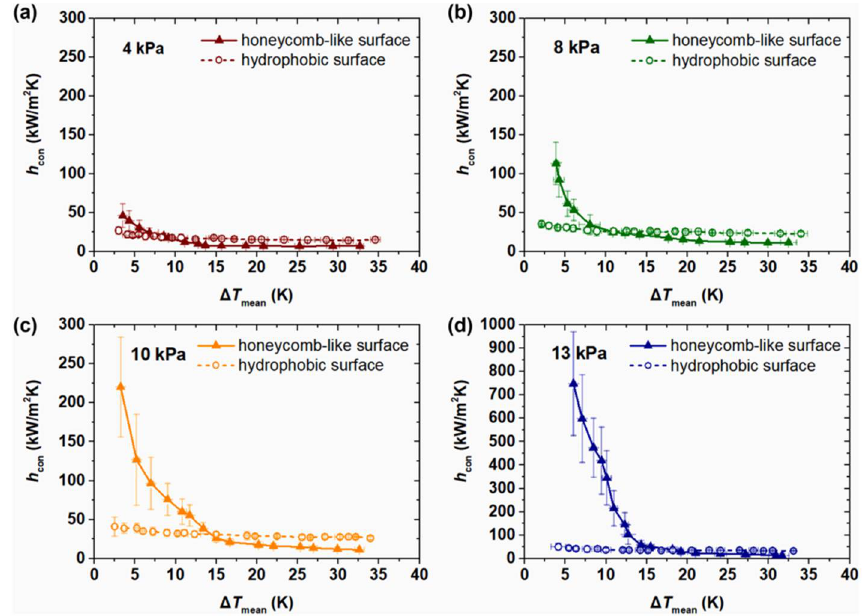
Figure 28. The condensation heat transfer coefficient on the honeycomb-like superhydrophobic and hydrophobic surface. ( a ) 4 kPa. ( b ) 8 kPa. ( c ) 10 kPa. ( d ) 13 kPa. Reprinted with permission from Ref [125]. Copyright 2021 Elsevier.